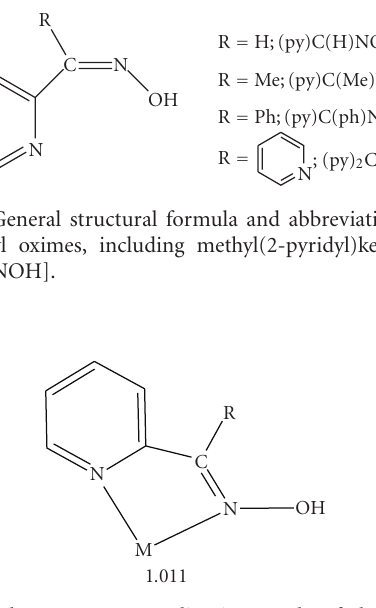
Scheme 2: The common coordination mode of the neutral 2- pyridyl oximes and the Harris notation [26] which describes this